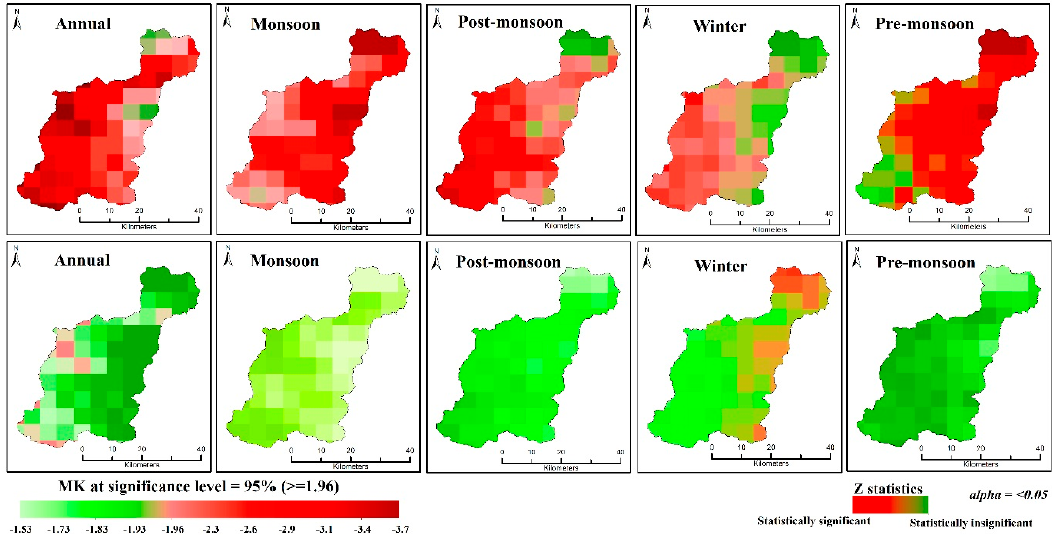
Figure 5. Spatial distribution of trends in annual and seasonal rainfall along with their statistical significance (1983–2008) (Top panel showing CHIRPS reanalysis and bottom PERSIANN-CDR satellite-based data products respectively).